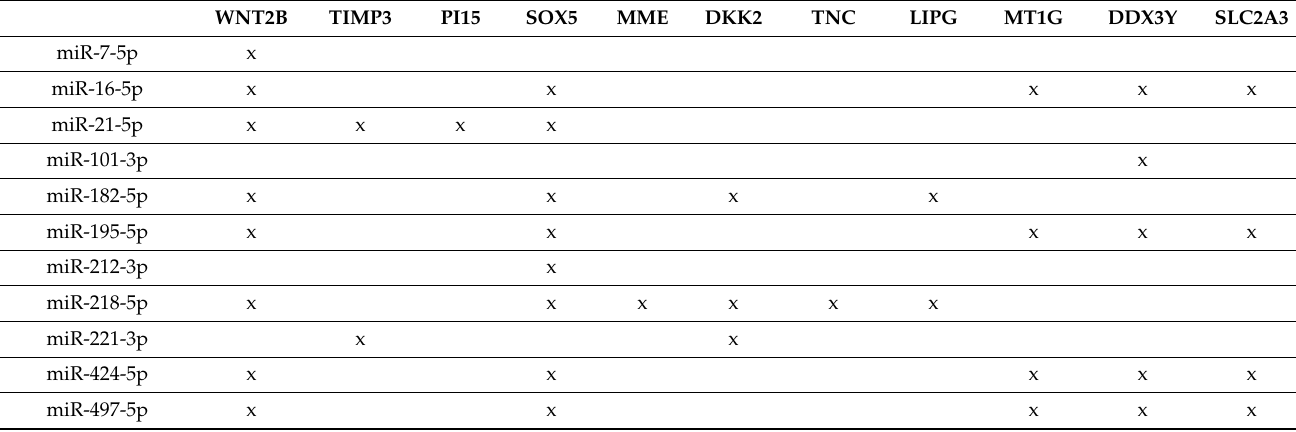
Figure 5. Expression of 11 selected miRNAs in skin biopsies putatively targeting early burn-response genes. Data are derived from 3 independent experiments and presented as individual values of –ddCt, normalized to SNORD 48 and U6 and expressed relative to control, with means (line) and standard deviation (whiskers). Significance was tested with Student ´ s t -test, followed by Bonferroni correction; p -values < 0.05 were considered as statistically significant, with * indicating p < 0.05. Table 3. Putative interactions between the analyzed miRNAs and mRNAs. The interactions are based on the TargetScan Human 7.2 search for conserved